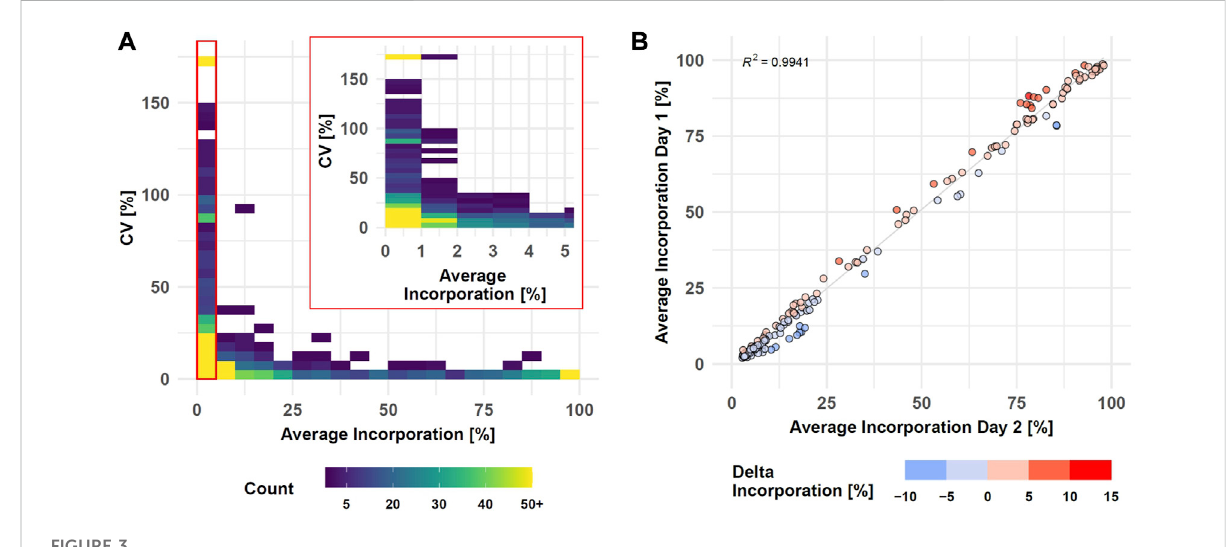
FIGURE 3 SIRMrobustnessevaluationafterdatapreprocessingwithtargetedlibrary(SupplementaryTableS1).Intra-dayreproducibilityassessedbyCVsof technicalreplicates(n=3)comparedtoaverageincorporationasdensityplot(seeSupplementaryTableS8,Day1dataset,samplings1,3,6,and24 h, 1585 isotopologues, binwidth = 5%) (A) . Inter-day reproducibility of SIRM experiments indicated as average tracer incorporation into 174 isotopologues on day 1 vs. day 2 (see Supplementary Table S9, tracer incorporation > 2% and < 100%) at 3 h sampling time point (B)